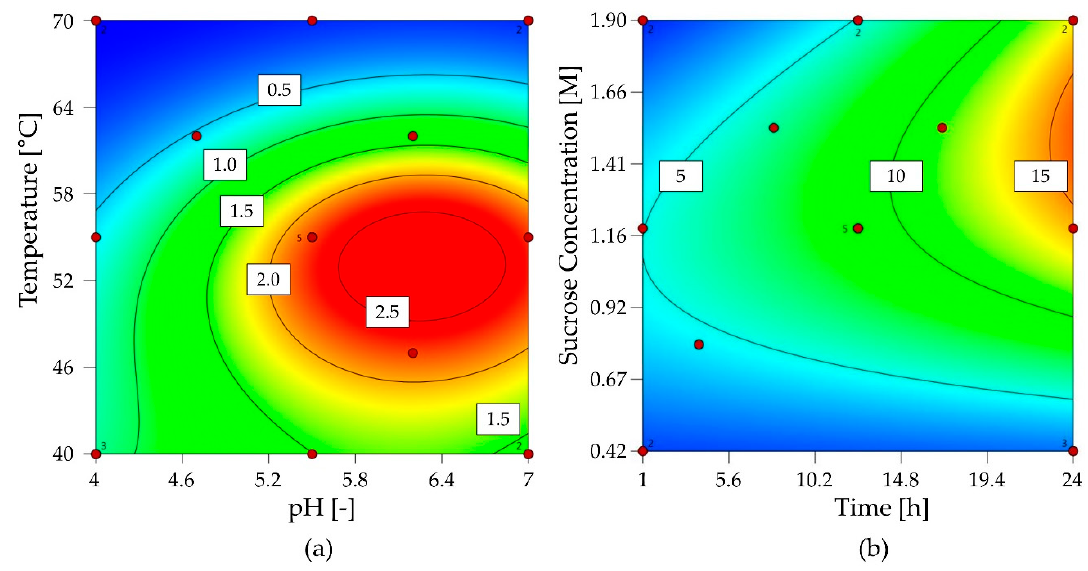
Figure 5. Contour plot of percentage FOS yield after catalysis with G 6 -FFT using a 5 × concentrated supernatant solution. ( a ) FOS yield as a function of pH and temperature (2 h reaction time, 1.63 M sucrose). ( b ) FOS yield as a function of time and sucrose concentration (pH 6.26, 53 °C).